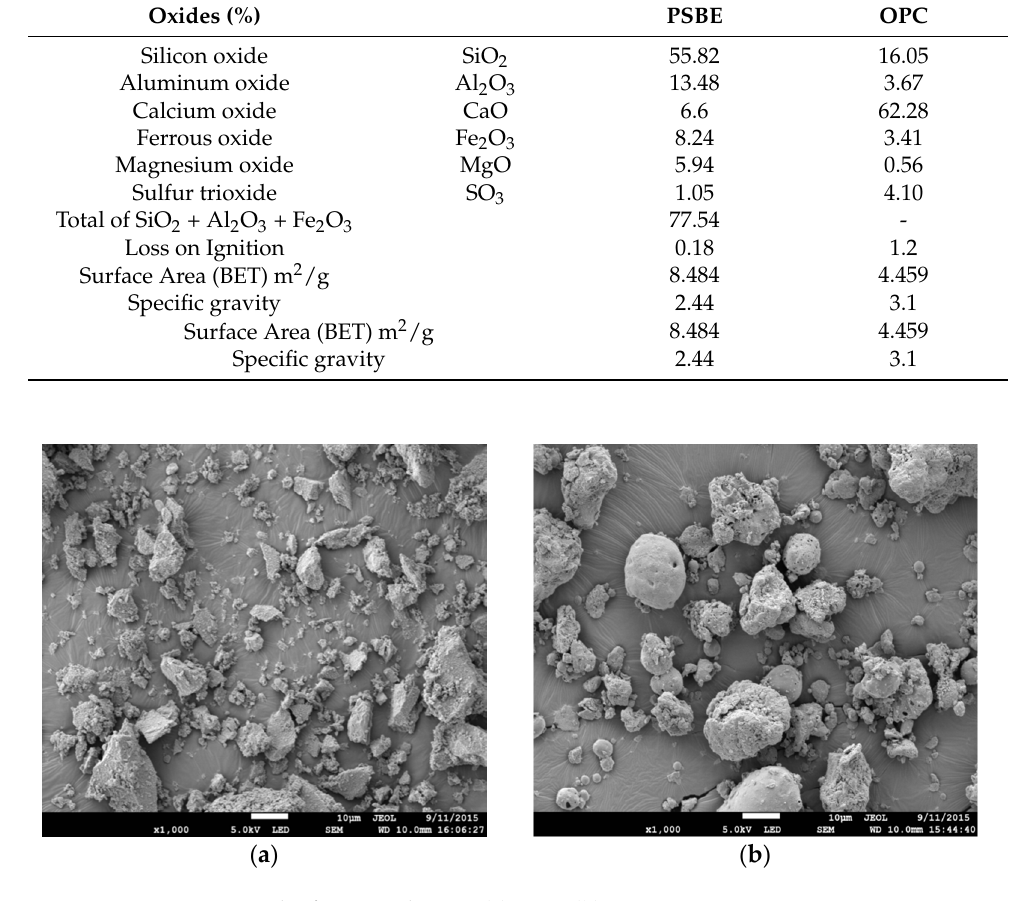
Figure 1. SEM micrograph of OPC and PSBE. ( a ) OPC, ( b ) PSBE. Table 1. Chemical composition of the OPC and PSBE.